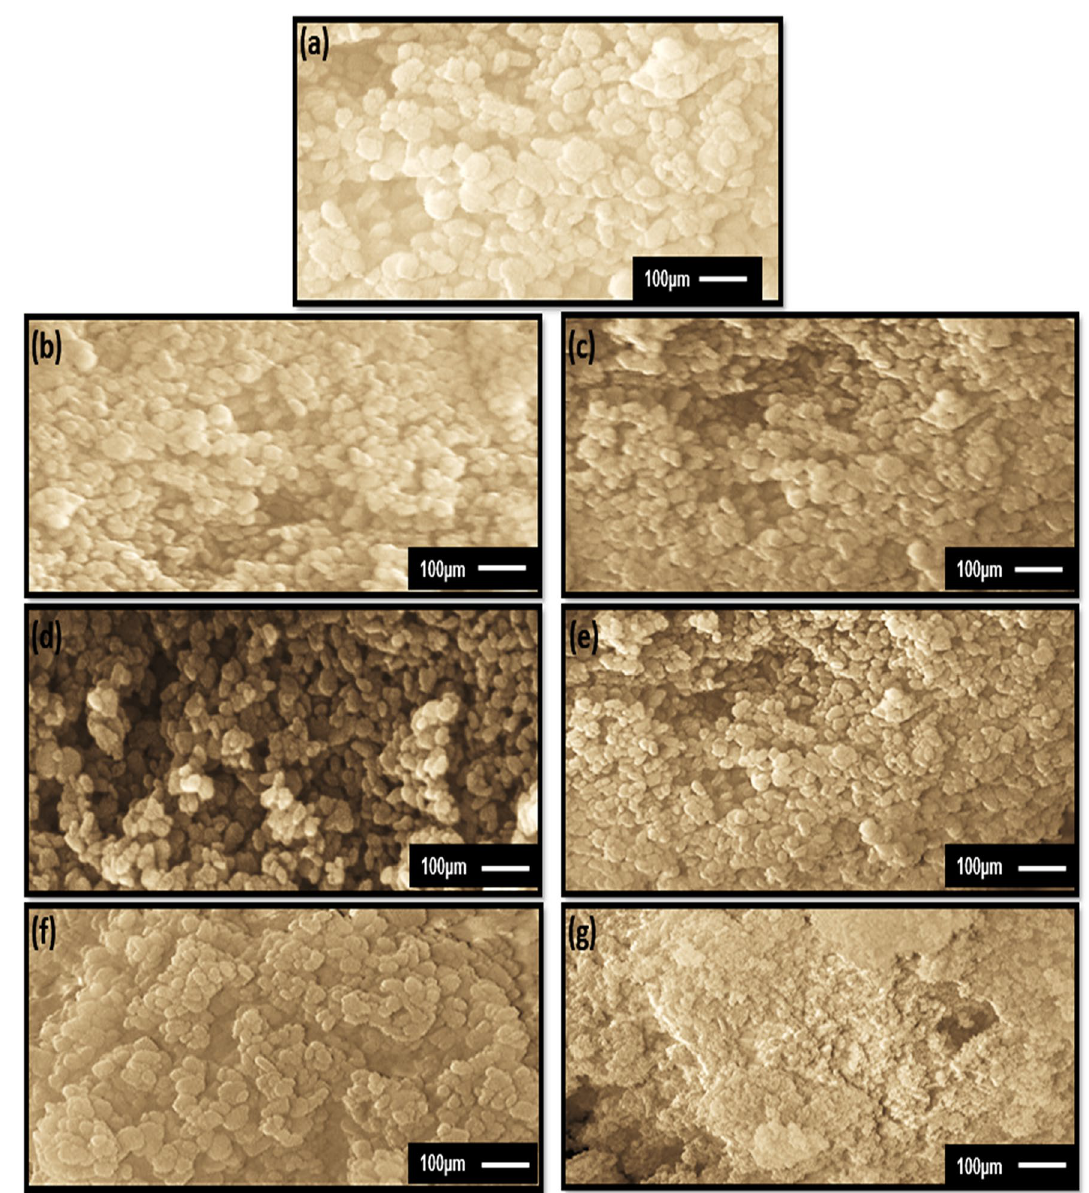
Figure 5. FE-SEM microstructures of ( a ) Pure MgO nanoparticles, and MgO nanoparticles doped with 3%, 7% of ( b,c ) Ni, ( d,e ) Co, and ( f,g )